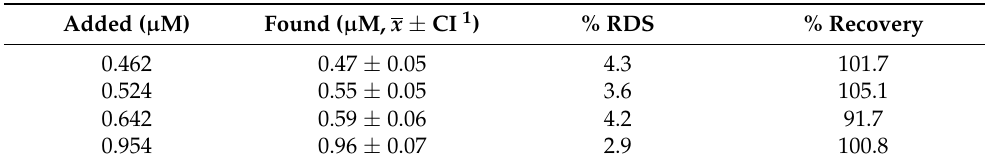
Table 3. Recovery experiments. Portions of a tap water sample, acidified at pH 1.5 with HCl and fortified with